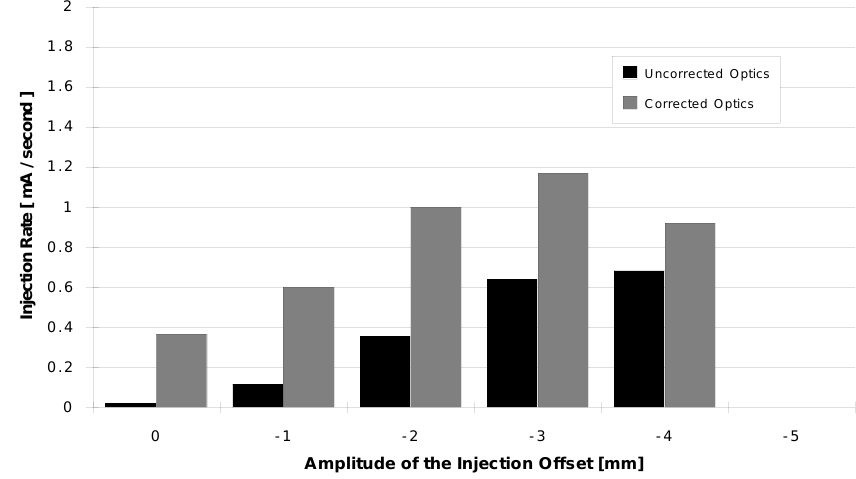
FIG. 8. A comparison of the injection rate, before and after the optic was corrected, as a function of the orbit distortion in the injection straight. (More negative means closer to the injection septum.)